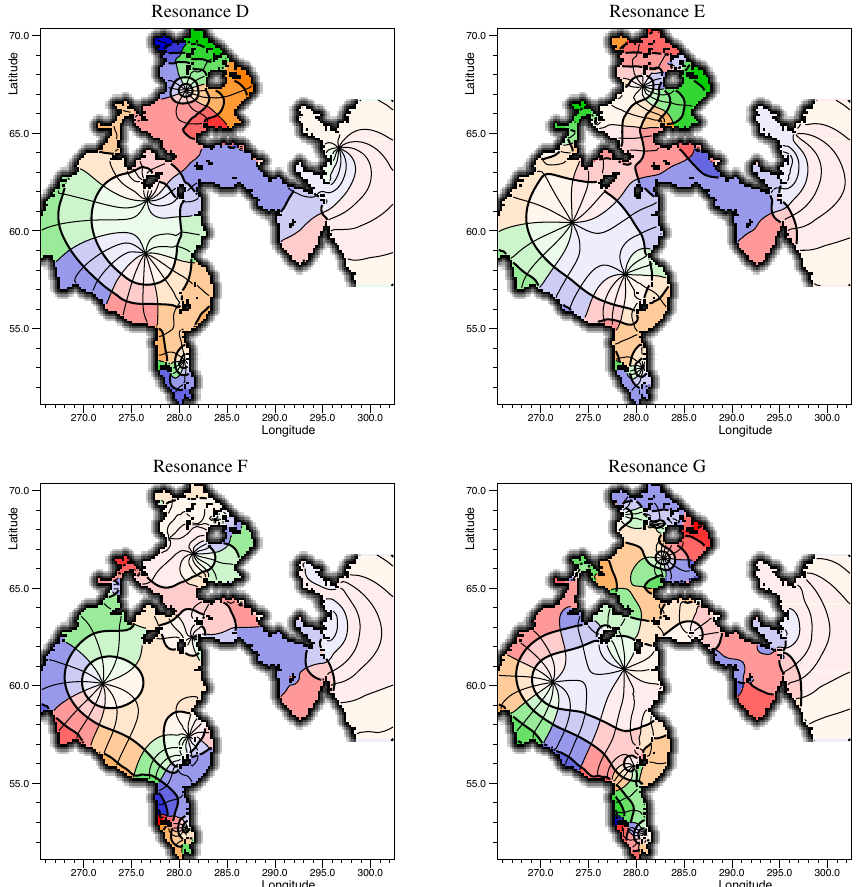
Figure 8. The amplitude and phase of resonances D to G of Table 2. Amplitudes normalised to one and phases are relative to the west side of Ungava Bay. Thick lines are contours of amplitude at 0.1, 0.2, 0.4, 0.6 and 0.8. Thin lines are contours of phase at intervals of 30 degrees. Colours as in Fig. 1, with zero phase between the red and blue areas.